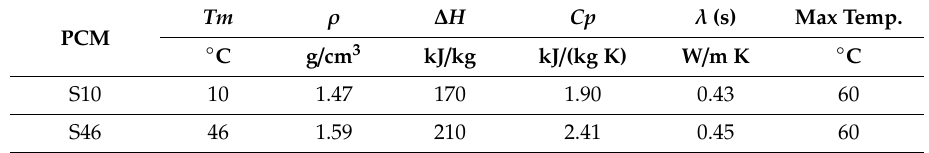
Table 3. Material properties of S10 and S46 phase-change materials from PCM Products Ltd.